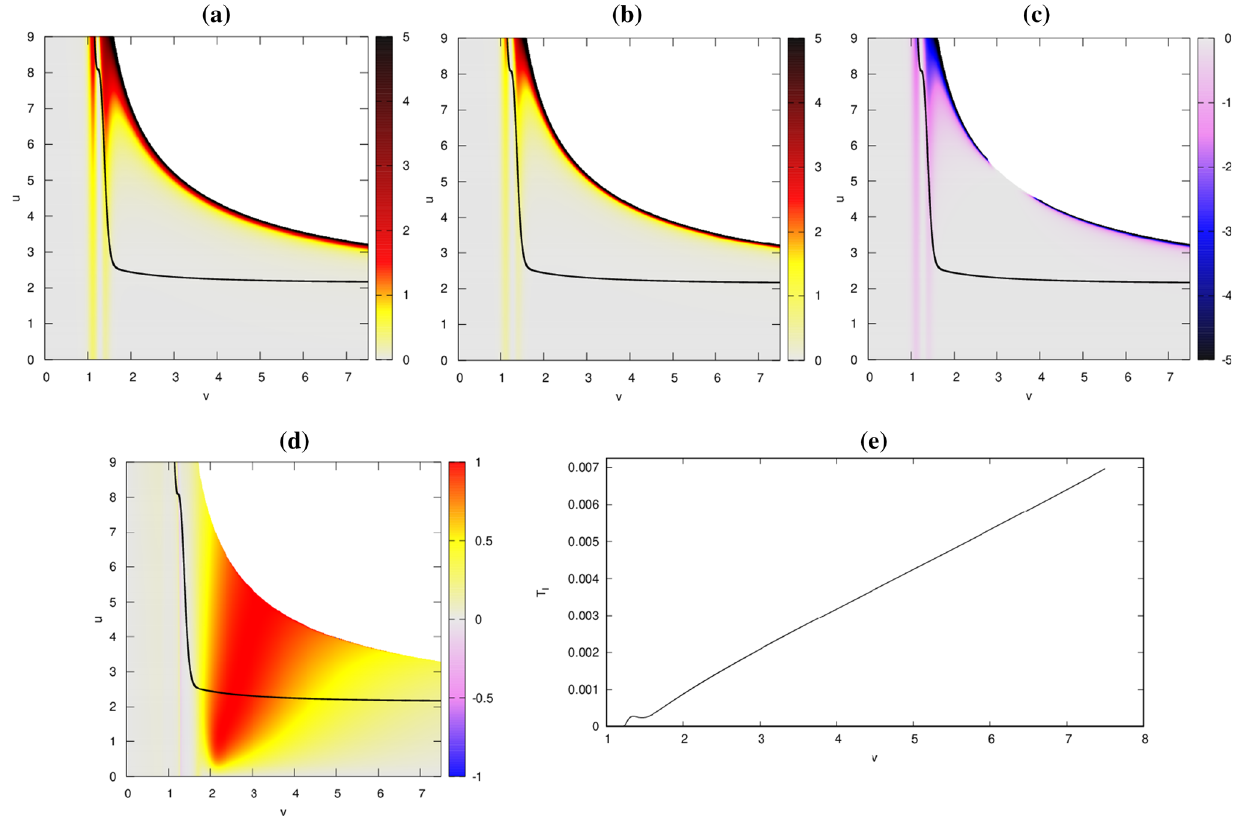
Fig. 13 The (v u ) -distribution of a energy density, ˆ ρ , b radial pressure, ˆ p ˆ p r , c pressure anisotropy, a , d tangential to radial pressures ratio, and e local temperature along the black hole apparent horizon, T l , as